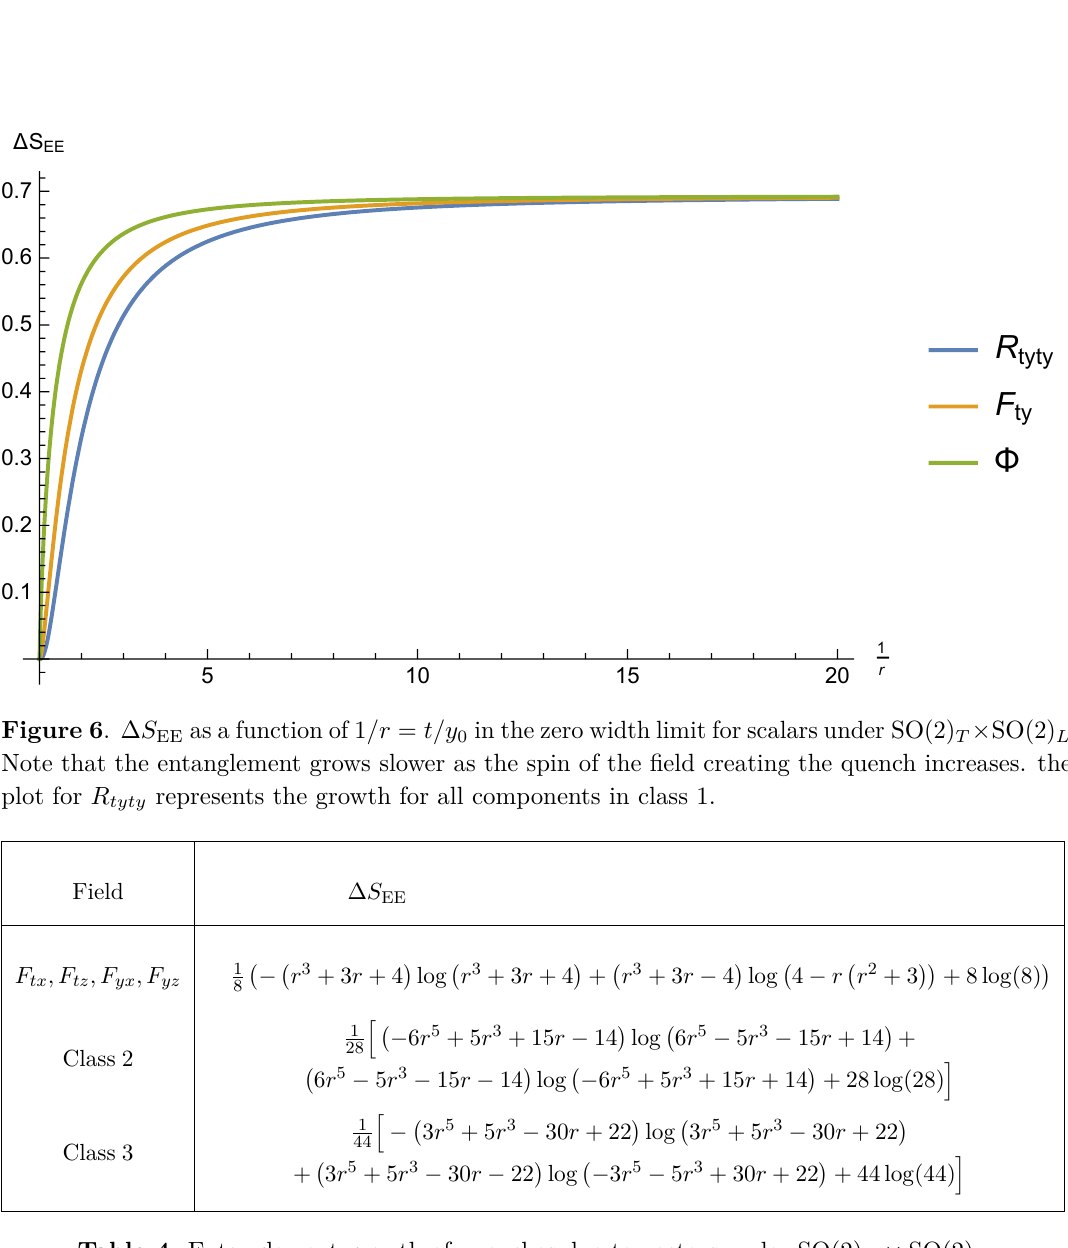
Table 4 . Entanglement growth of quenches due to vectors under SO(2) T × SO(2) L